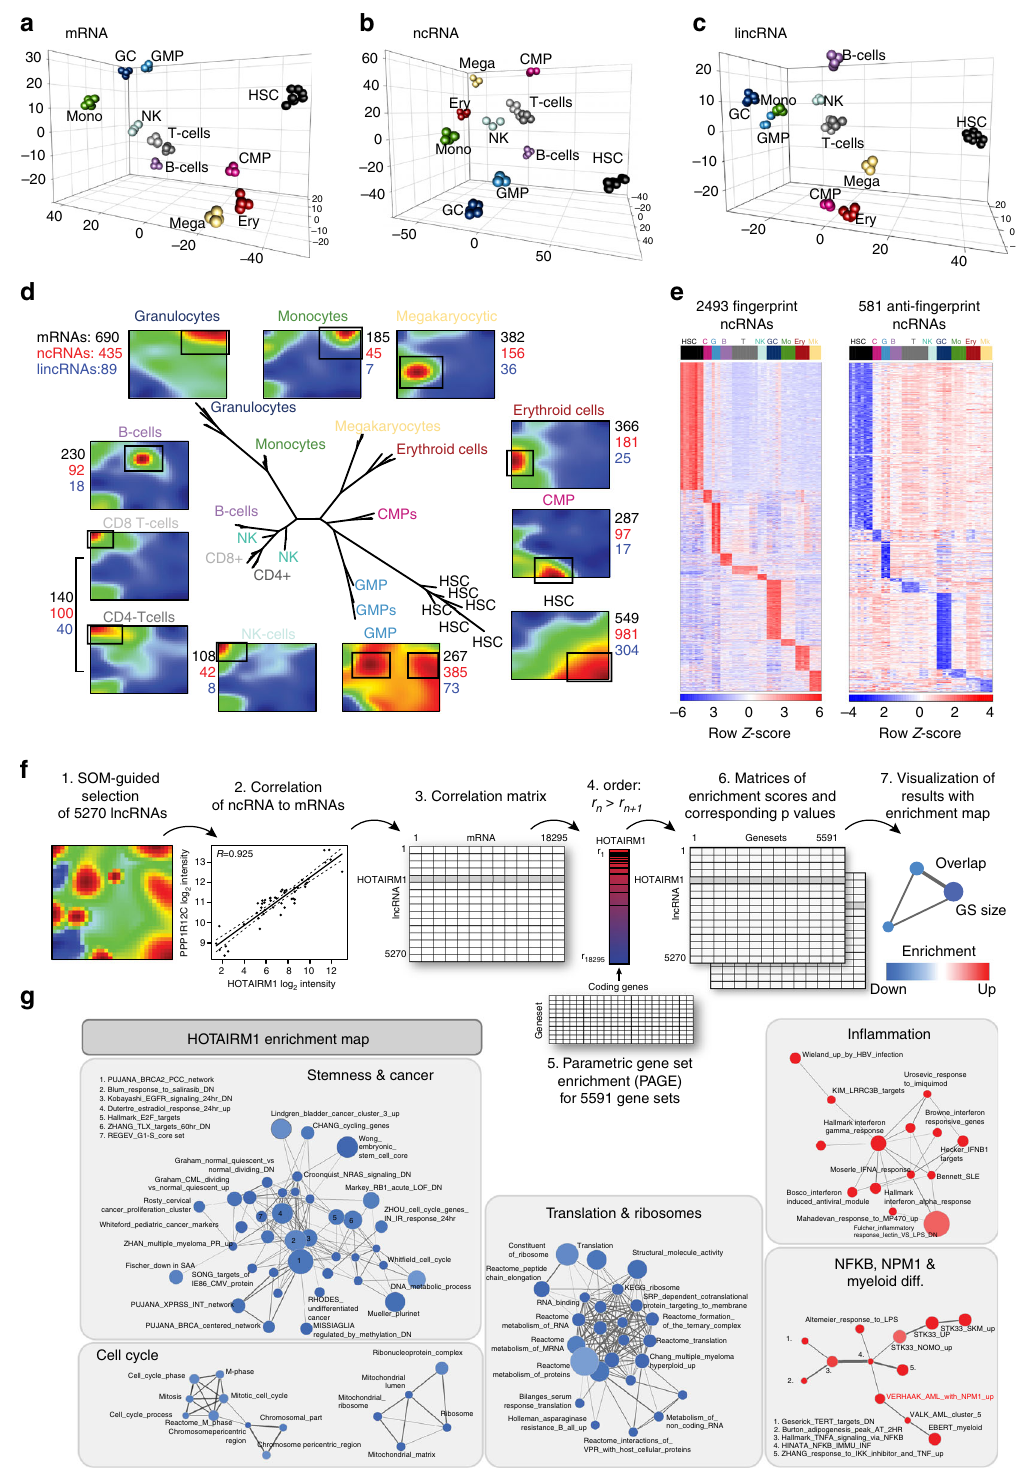
Fig. 2 Distinct ncRNA expression pro fi les characterize cells of the different human blood lineages. All depicted data refer to the Arraystar Human lncRNA Microarray V2.0 platform. a – c t -SNE of all samples using the most variable a mRNAs (3926), b ncRNAs (3151), and c lincRNAs (767). d Self-organizing maps ( SOMs ) trained using the 17,655 most variable mRNAs and ncRNAs in 11 sample groups. Black rectangles : group-speci fi c overexpression spots. Center : neighbor- joining tree built using the 68 lineage-speci fi c spot metagenes. e Heatmaps of ( left ) 2493 fi ngerprint ncRNAs and ( right ) 581 anti- fi ngerprint ncRNAs, de fi ned by integrating SOM and limma analyses. f Guilt-by-association work fl ow for the fi ngerprint/anti- fi ngerprint ncRNAs and all protein-coding genes. g Enrichment map network analysis for HOTAIRM1 (FDR < 0.05, see the methods section for details). Circle size corresponds to the size of the gene set, and connecting line thickness represents the degree of similarity between two gene sets. Red and blue nodes indicate positive and negative correlation to HOTAIRM1 expression, respectively. Gene set labels printed in bold indicate a similar association (FDR < 0.05) observed in at least one AML validation